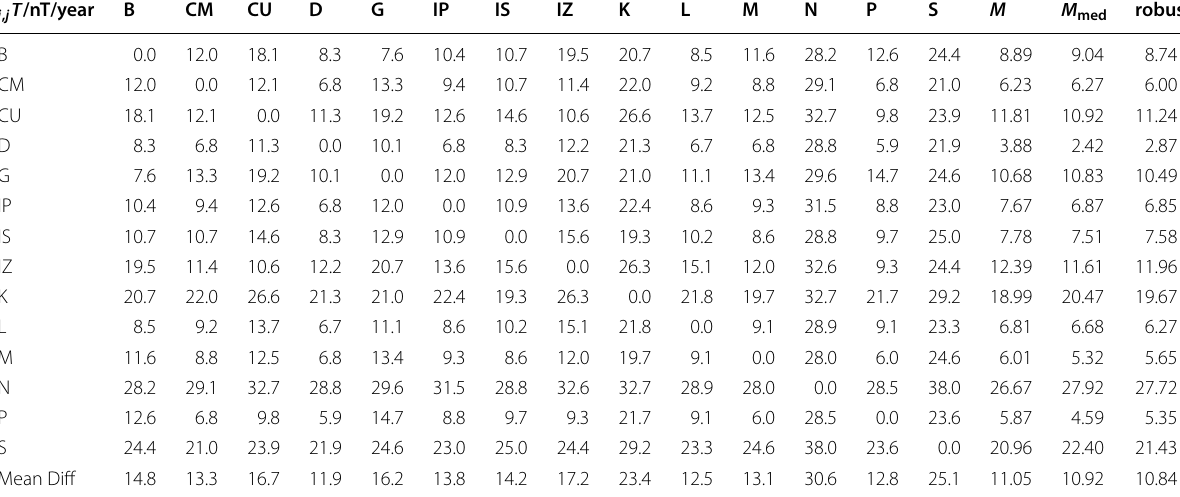
The bottom row is the simple arithmetic mean of the columns